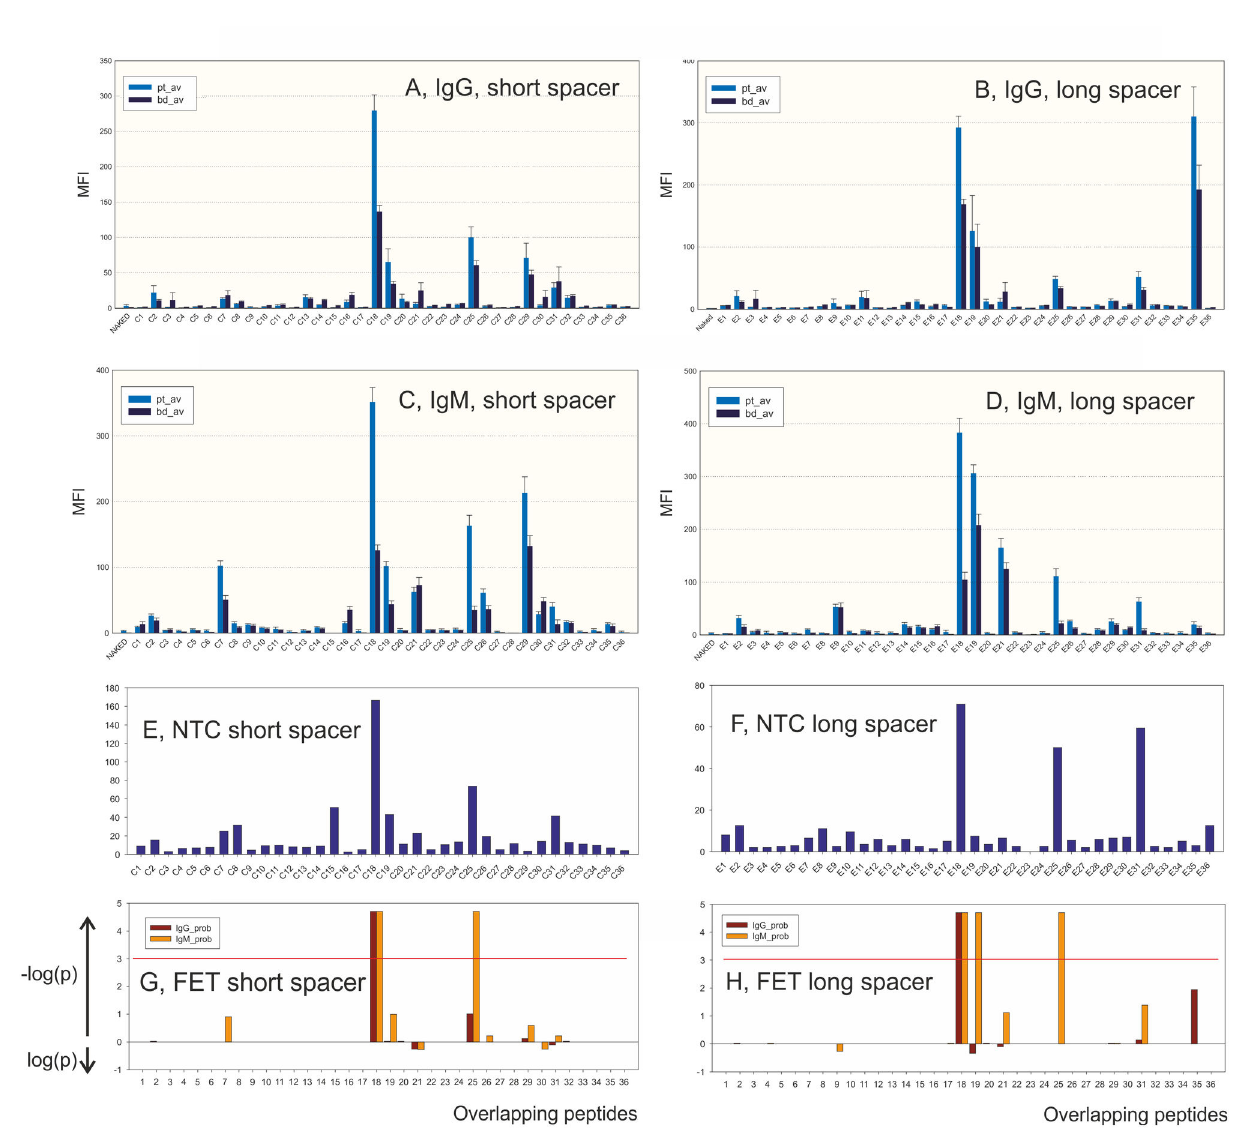
Figure 3. Epitope scanning with overlapping Chlamydia pneumoniae HSP60 peptides coupled with short (tri-ethylene glycol; C series) and long (hexa-ethylene glycol; E series) spacer. Reactions (MFI, after subtraction of NTC values) in the IgG and IgM assays, were measured. Frames E and F show the NTC values. Frames G and H show the probabilities calculated according to the Fisher Exact Test. The red line shows an estimated probability of